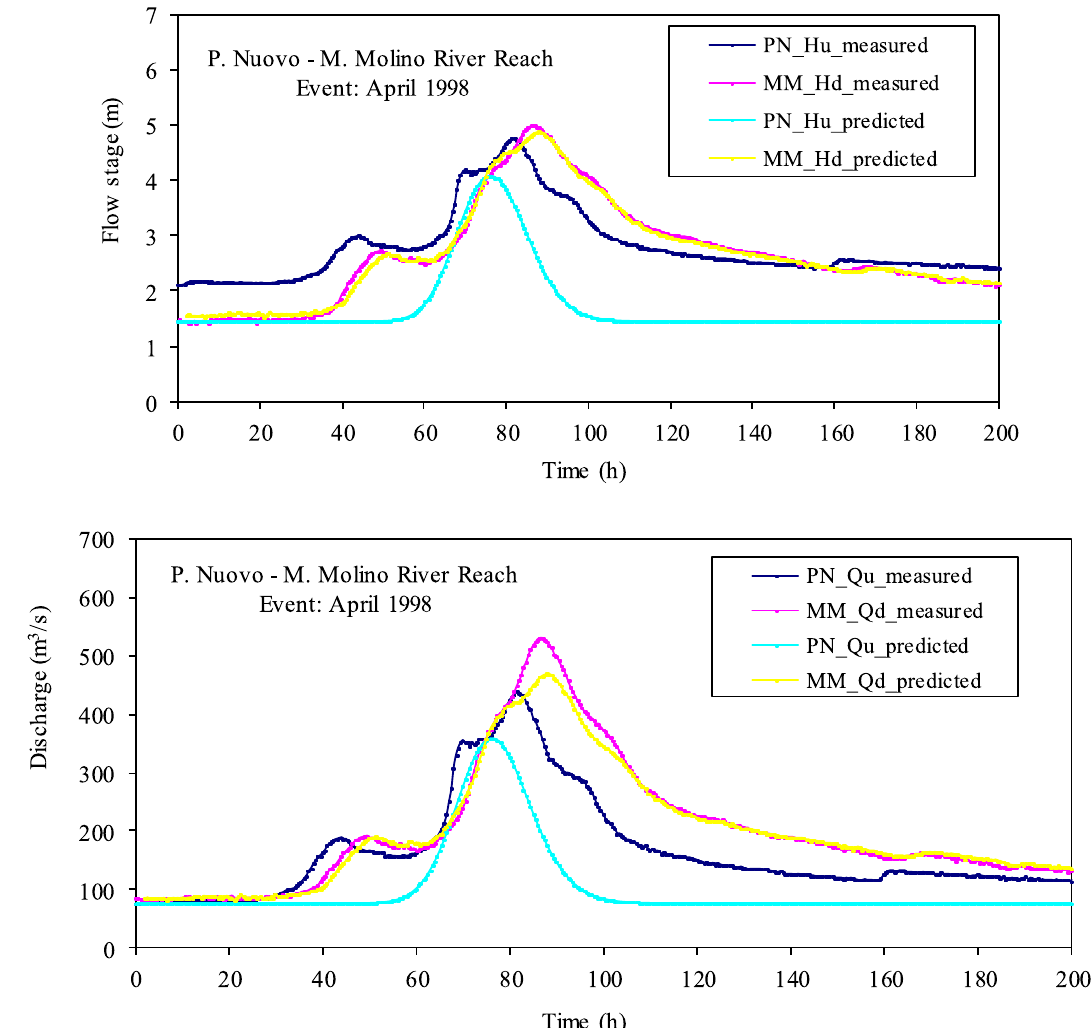
Fig. 8 Flow stage (above) and flow discharge (below) hydrograph simulations for event April 1998 in P. Nuovo and M. Molino river